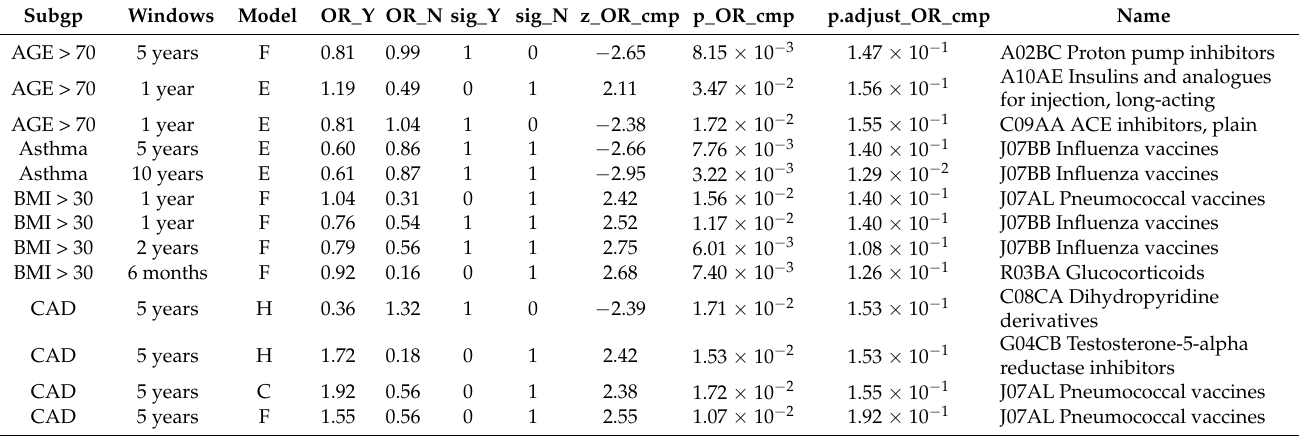
Table 7. Summary of subgroup analysis, showing drugs having significant protective association in one subgroup but significantly different OR in the other subgroup (FDR < 0.2).